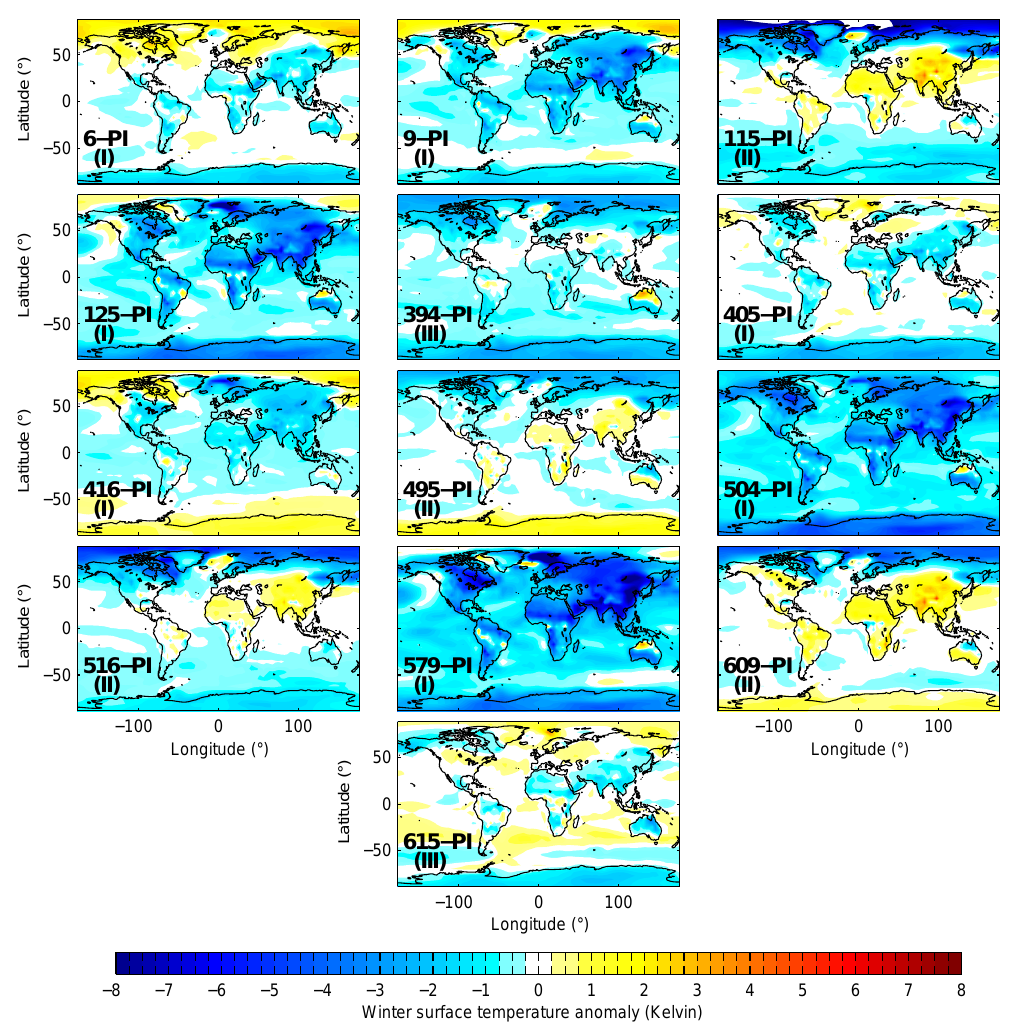
Figure 4. As in Fig. 3, but for boreal